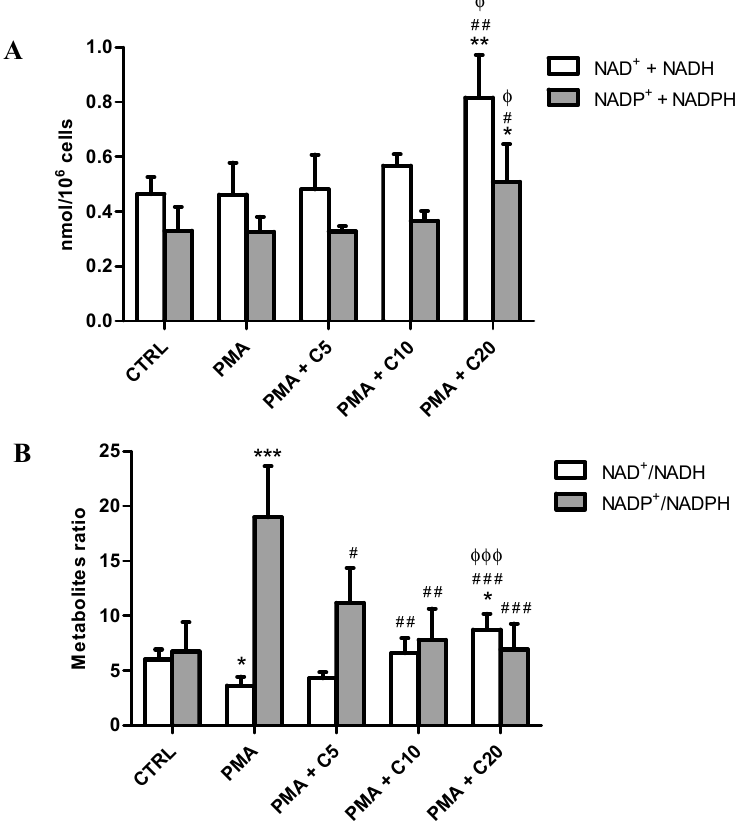
Figure 3. Consequences of the different cell treatments on ( A ) the sum (NAD + + NADH and NADP + + NADPH) and ( B ) the ratio (NAD + /NADH and NADP + /NADPH) of intracellular nicotinic coenzymes in resting (control) macrophages and in macrophages stimulated with PMA and SOD inhibitors, in absence or presence of increasing concentrations (5, 10, or 20) of carnosine. The sum of intracellular nicotinic coenzymes is expressed as nmol/million cells. Values are means ± SD of four independent experiments. * p < 0.05 vs. CTRL; ** p < 0.01 vs. CTRL; *** p < 0.001 vs. CTRL; # p < 0.05 vs. PMA; ## p < 0.01 vs. PMA; ### p < 0.001 vs. PMA; ϕ p < 0.05 vs. PMA + C5 and PMA + C10; ϕϕϕ p < 0.001 vs. PMA +